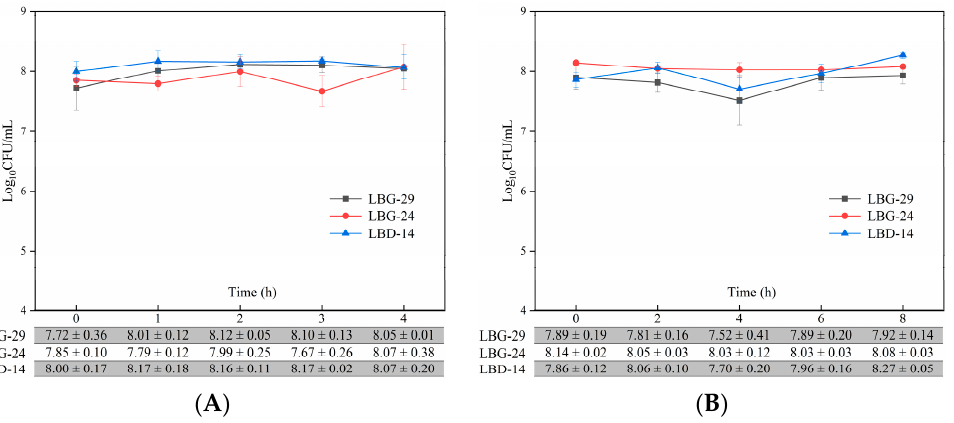
Figure 3. Tolerance of the three Levilactobacillus brevis strains to human gastric juice ( A ) and intestinal fluid ( B ) under simulated satiety in vitro. Values are means ± SD.